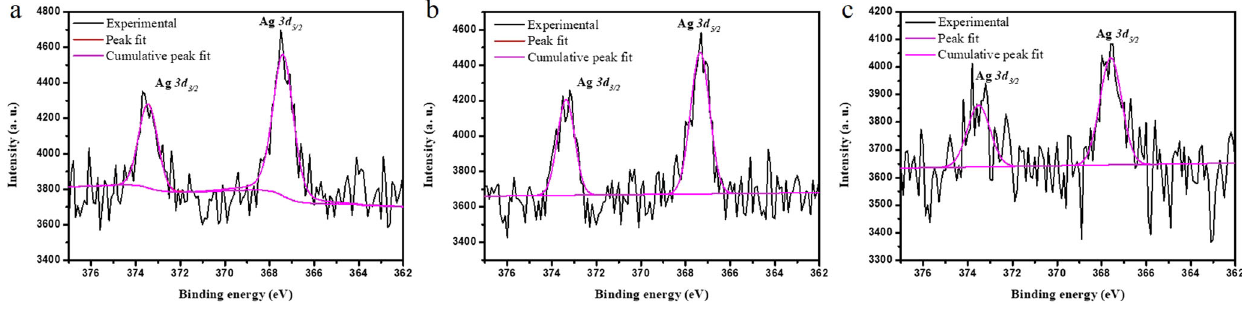
Fig. 3 The Ag 3d XPS spectra of SCNF/Ag composite NF membrane. The Ag 3d XPS spectra of a L-SCNF/Ag-0.01, b MSCNF/Ag-0.01 and c